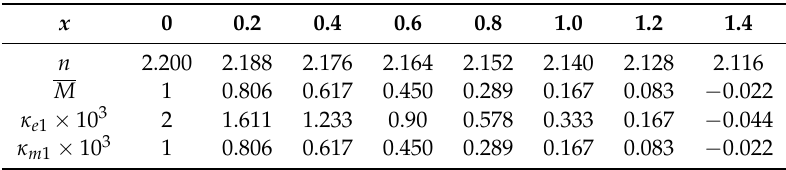
Figure 4. Difference in effective guide indices, N + in a monomode dielectric circular cylindrical waveguide with the axial magnetization as a function of Ga content, x , in yttrium iron garnet, Y 3 Fe 5 cases: (1) For the case where both the core and the cladding are characterized by the permittivity and permeability tensors (magnetic cladding). (2) For the case where the core remains characterized by the permittivity and permeability tensors while the isotropic cladding is characterized by scalar permittivity and permeability (nonmagnetic cladding). Table 1. Effect of diamagnetic substitution, x , in yttrium iron garnet, Y 3 Fe 5 of refraction, n , relative magnetization, M , and the off-diagonal relative permittivity and permeability tensor elements, κ e 1 and κ m 1 .